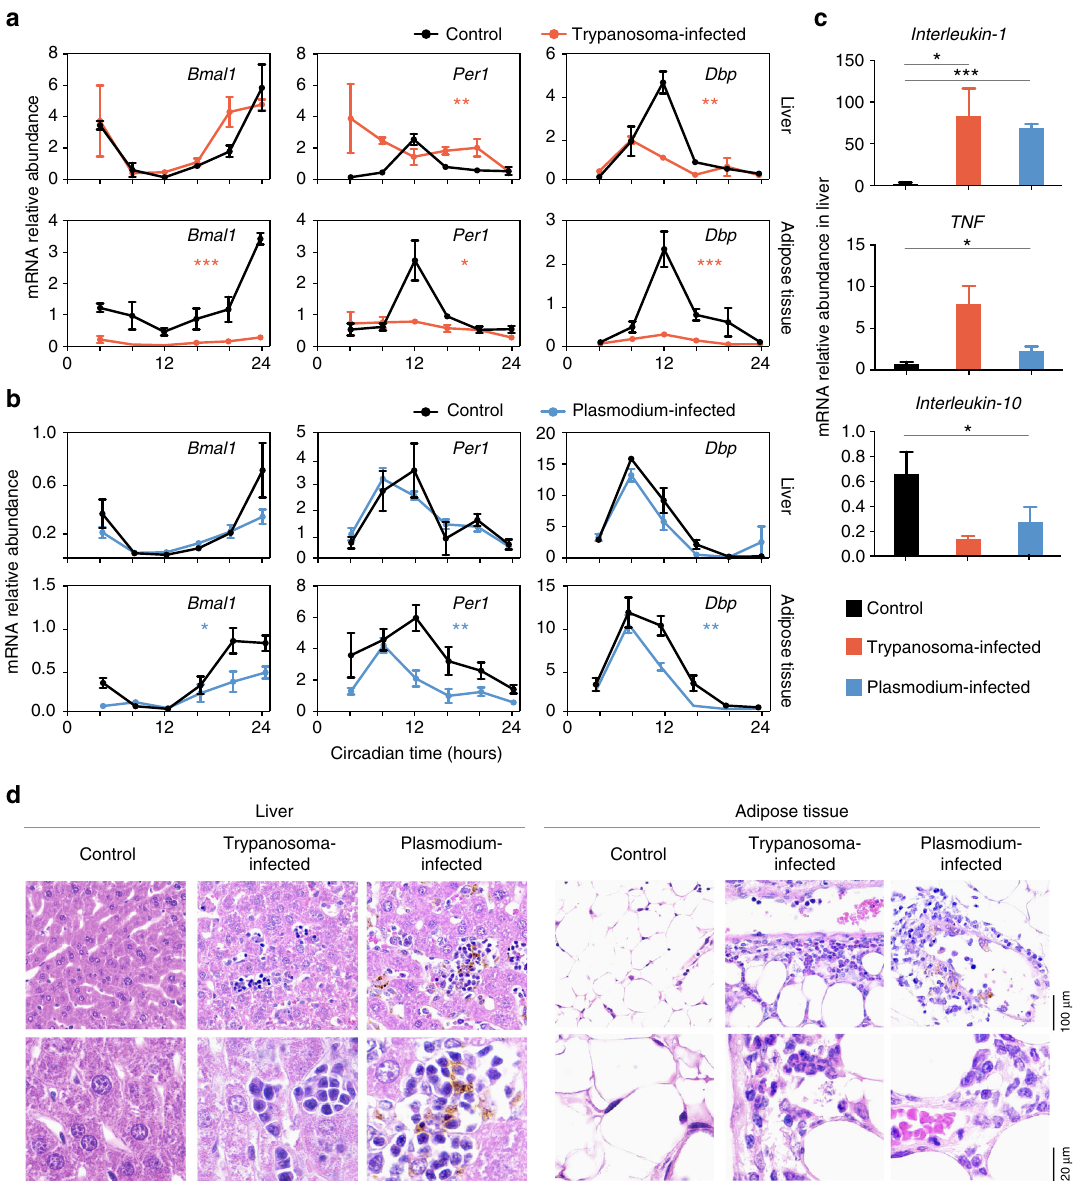
Fig. 4 Shorter period in circadian clock genes is T. brucei speci fi c. a Real-time qPCR analysis of clock gene expression in control (black) and Trypanosoma- infected (orange) mice. b Real-time qPCR analysis of clock gene expression in control (black) and Plasmodium-infected (blue) mice. Two organs are shown, liver and gonadal adipose tissue. Error bars represent ± s.e.m. for each time point from three mice. Two-way ANOVA comparing differences between groups shows signi fi cant statistical differences between control and Trypanosoma-infected mice, * p < 0.05, ** p < 0.01, *** p < 0.001. For visualization purposes, points are united with a line. c Real-time qPCR of cytokine mRNA expression in liver; **adjusted p < 0.01, *** p < 0.001, FDR method Benjamini – Hochberg. d Representative microphotographs of liver and gonadal adipose tissue from non-infected, Trypanosoma-infected and Plasmodium- infected mice; depicted are the in fl ammatory cell in fi ltrates (arrow) seen in both tissues, for both infection models; n = 5 per condition. Hematoxylin and Eosin. Original magni fi cation ×40 (upper panel) and ×100 (lower